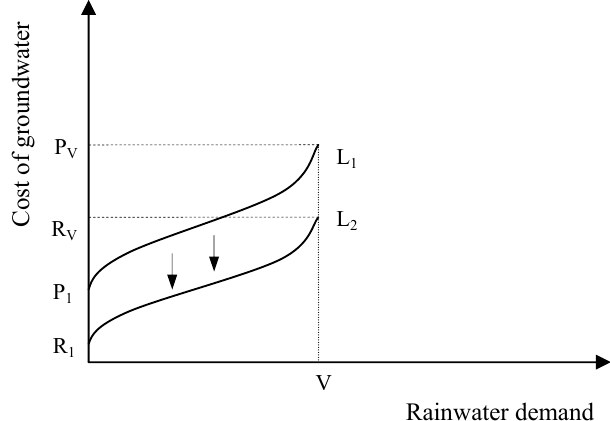
Figure 6. Movement of rainwater demand lines. (L means lines; R means cost of